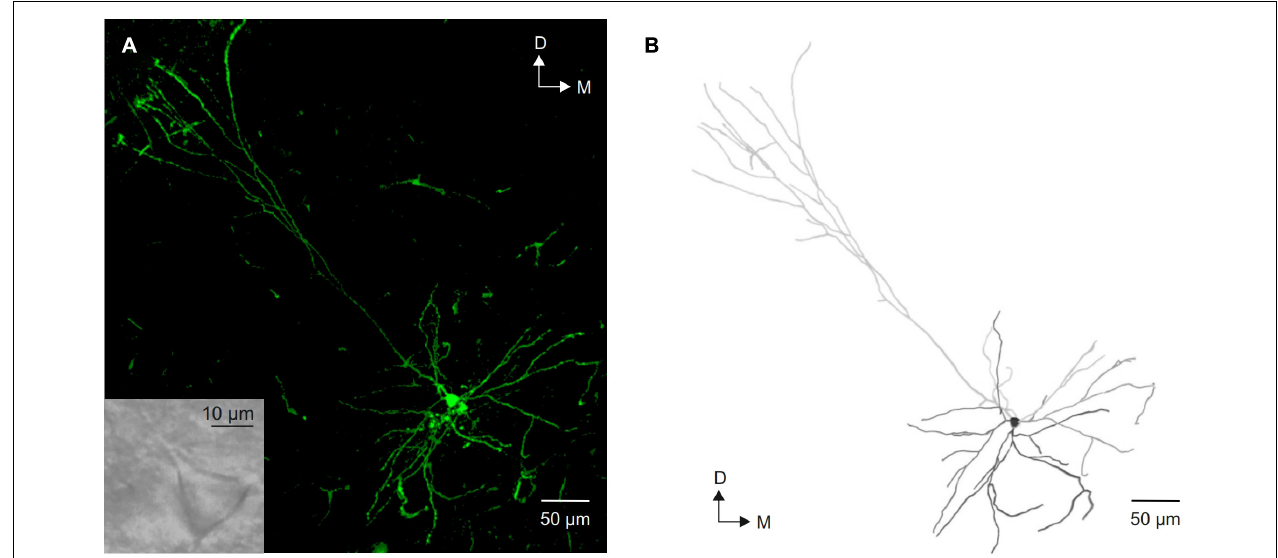
FIGURE 1 | Morphological identification of layer V pyramidal neurons from the motor cortex. (A) Photomicrograph of a intracellular labeled layer V pyramidal neuron showing its typical morphology. The inset shows an image of this neuron under infrared microscope visualization. (B) Neurolucida reconstruction of the neuron shown in (A) . D, dorsal; M,